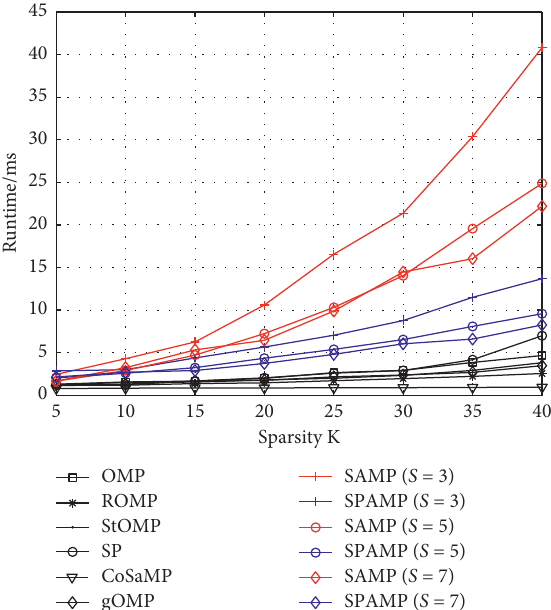
Figure 8: Average runtime versus